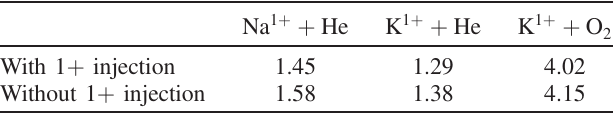
TABLE IV. Comparison of plasma effective charge h Z and without 1 þ injection.